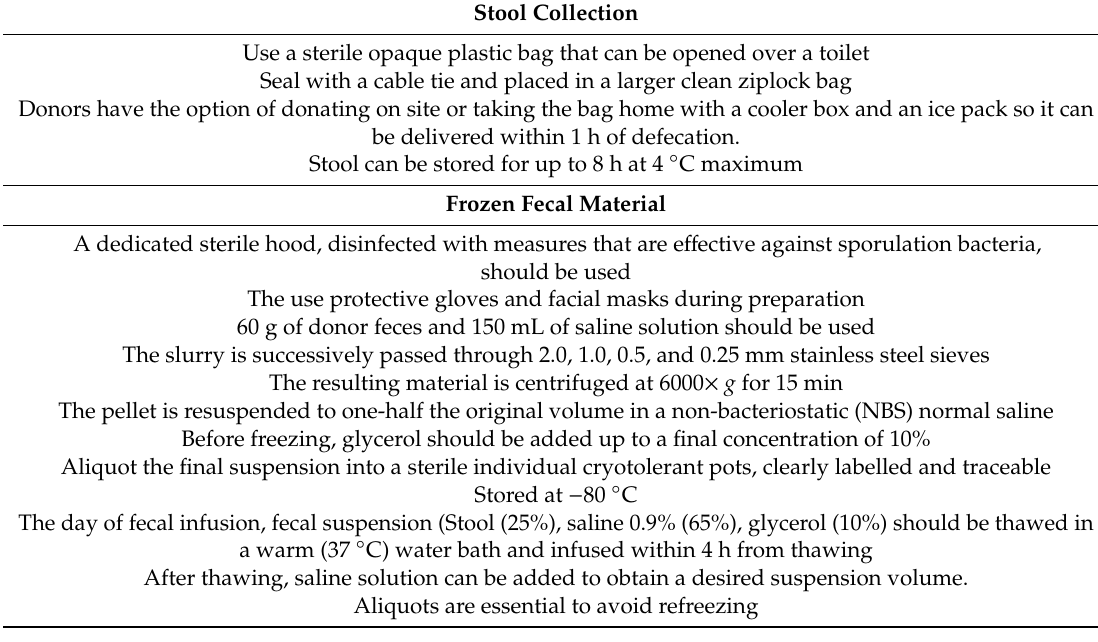
Table 4. List of existing worldwide stool banks.